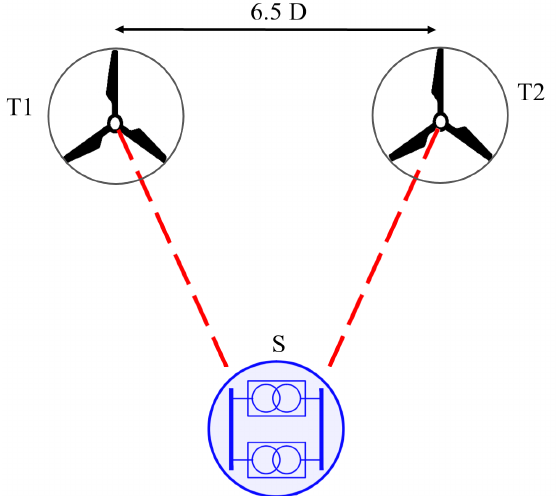
Figure 16. Wind farm layout. T is the wind turbine, D the rotor diameter and S the electrical substation. The platform is moored by three catenary lines and it is anchored by three drag-embedded